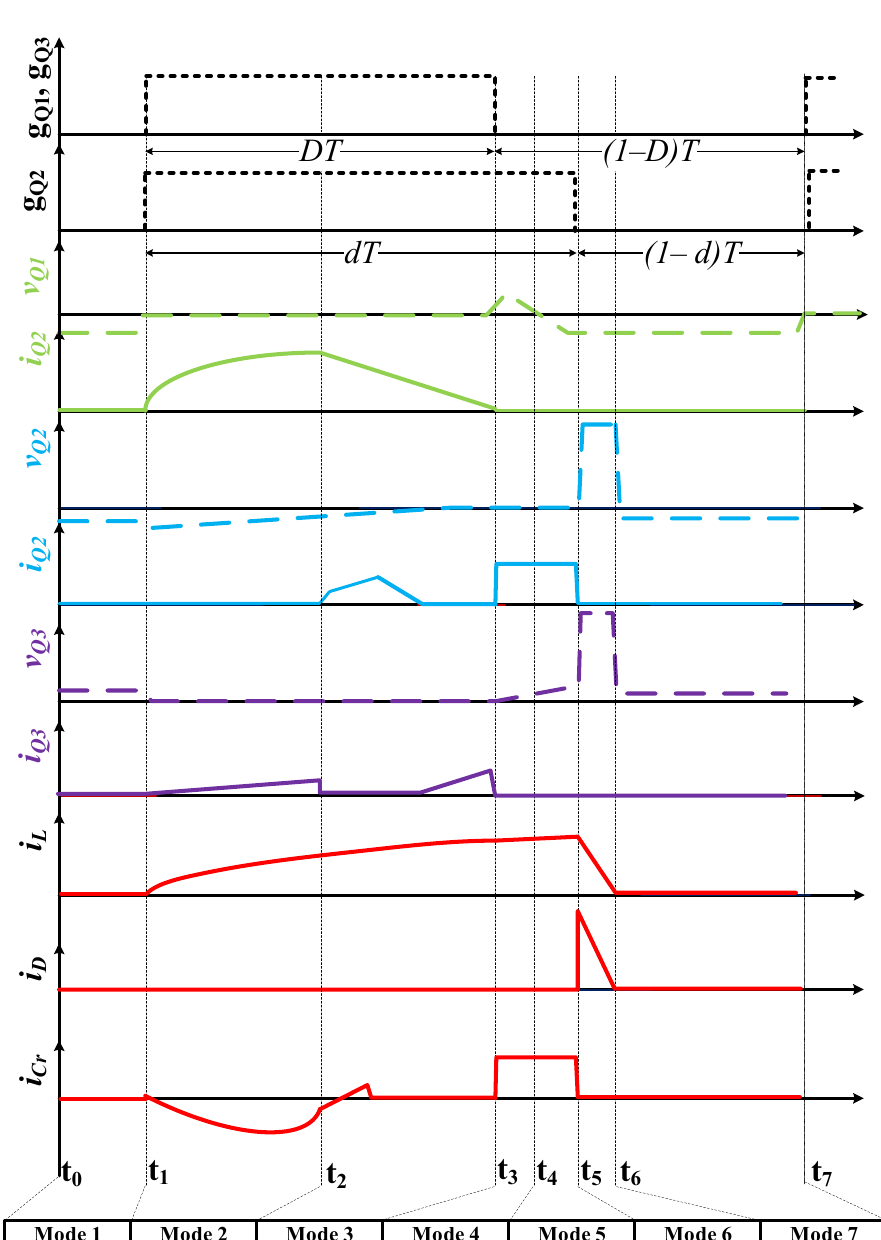
In the third time interval ( t 3 ≤ t ≤ t 4 ), Q 2 is on and v Cr is zero. Q 3 is already turned on in ZVS at t 1, and its voltage is zero. Then, Q 3 starts conduction in ZVS and L is